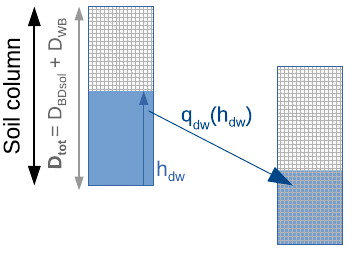
Figure 4. DWF model of flow generation by infiltration at depth and support of a deep aquifer q dw (h dw ) (Eq. 1).